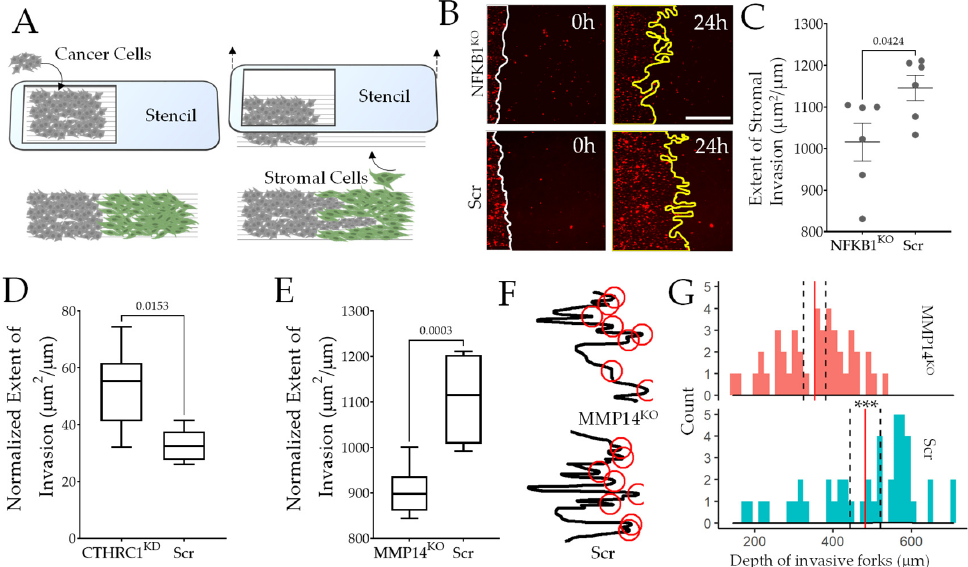
Figure 6. Experimental validation of causality of genes identified in pro-invasable and pro-resistive stromal clusters to regulate stromal resistance to cancer invasion. ( A ) Schematic showing setup to measure stromal invasibility, ANSIA (Accelerated Nanopatterned Stromal Invasion Assay); fluorescently labeled cancer cells are patterned with stromal fibroblasts to create a collective interface between the two orthogonal to the underlying anisotropic nanopatterned fiber direction; cancer invasion is measured for 24 h using live cell fluorescent microscopy. Here, invading cancer cells are the constant, while the invaded fibroblasts are perturbed with siRNA- or CRISPR/Cas9-mediated gene silencing. ( B ) Representative images of cancer cells invading BJ fibroblasts with or without CRISPR/Cas9-based gene knockout for NFKB1, a key leading gene in pro-invasable cluster 5, with quantified extent of cancer invasion shown in ( C ). ( D ) ANSIA-based quantification of stromal invasion with a key gene characterizing pro-resistive cluster 5, CTHRC1 silenced in fibroblasts. ( E ) ANSIA-based quantification of stromal invasion with a key gene characterizing pro-invasable cluster 4, MMP14 silenced in fibroblasts. ( F ) Representative invasive front interface of cancer cells into the monolayer of control fibroblasts, and silenced for MMP14; Automated peak identification denoted by red circles; ( G ) Distribution of the length of invasion in either stromal monolayer by identified invasive forks shows that MMP14 gene silencing reduces deep collective invasion. In ( D , E ), n = 6 locations; in ( G ), p -value = 9.948 × 10 − 7 , denoted as ***.